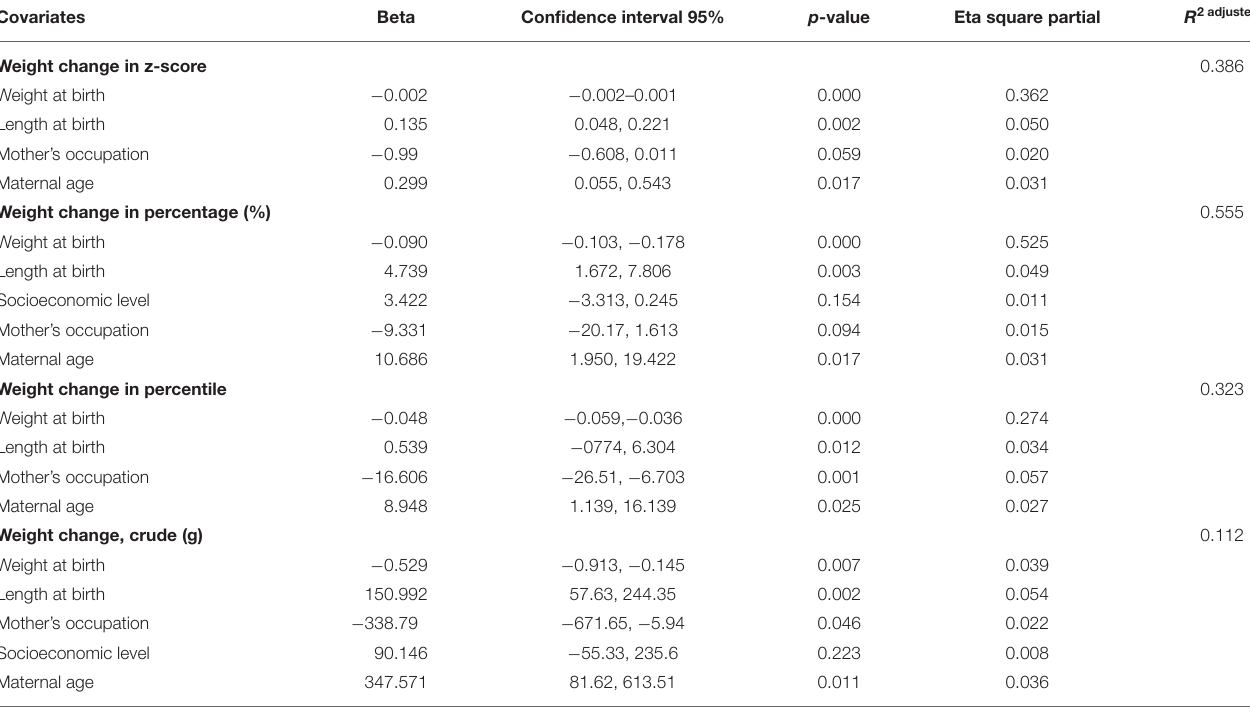
TABLE 5 | Univariate general linear model to determine the predictor variables of weight change parameters. Covariates